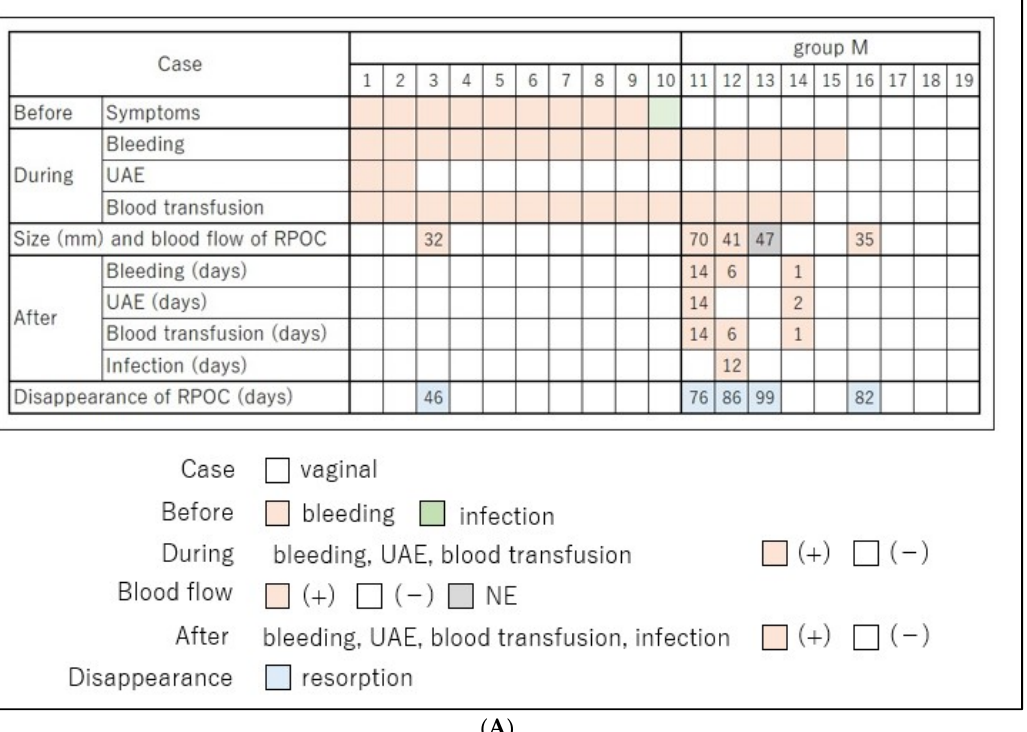
Figure 2. ( A ). Clinical courses of 19 cases with placental removal within 24 h after delivery. The numbers in “Size and blood flow of RPOC” indicate the size of RPOC (mm). The numbers in “After” and “Disappearance of RPOC” indicate the duration from delivery to the onset of the events (days). RPOC, retained products of conception. ( B ). Clinical courses of 22 cases with conservative manage- ment. The numbers in “Size and blood flow of RPOC” indicate the RPOC size (mm). The numbers in “Events” and “Disappearance of RPOC” indicate the duration from delivery to the onset of event (days). RPOC: retained products of conception. 3.2. Twenty-Two Cases with Conservative Management Twenty-two patients were treated conservatively (group C). Overall, 3 of the 22 cases were delivered via cesarean section. The median RPOC diameter was 46 mm, with five cases exceeding 100 mm (Figure 2B). Seventeen cases had blood flow in RPOC on contrast-